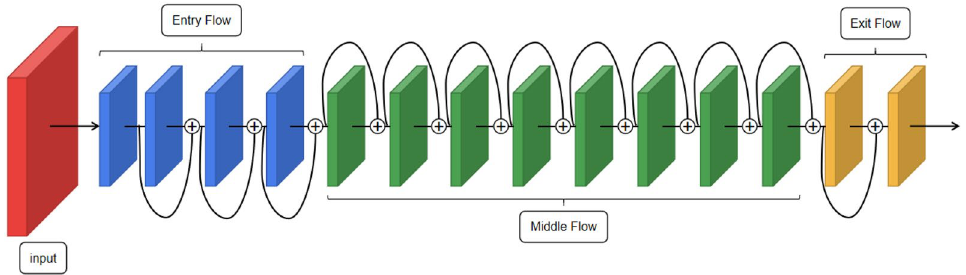
Figure 3. Xception module